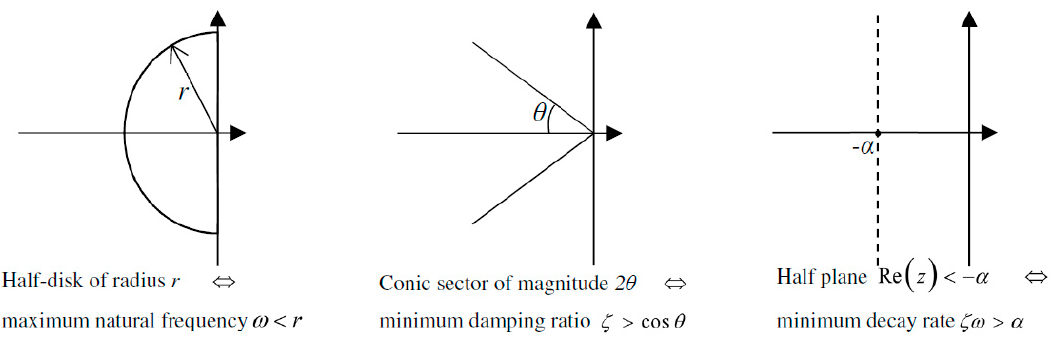
Figure 1. Examples of Linear Matrix Inequalities (LMI) regions.